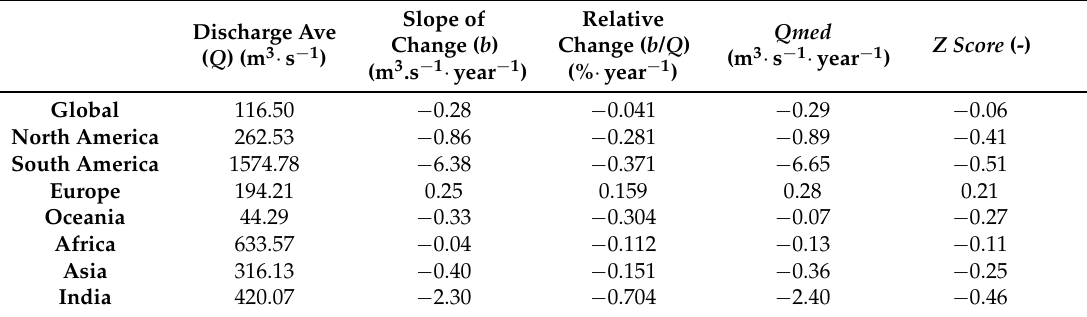
Table 4. Global and continental-averaged trend results of the WBM streamflow simulations based on the WFD observation-based inputs, from 1971 to 2001. The average discharge magnitude ( Q ) values are per grid cell. The Qmed and Z-score indices are obtained from the Sen’s slope estimator and Mann-Kendall methods, respectively, for the streamflow.